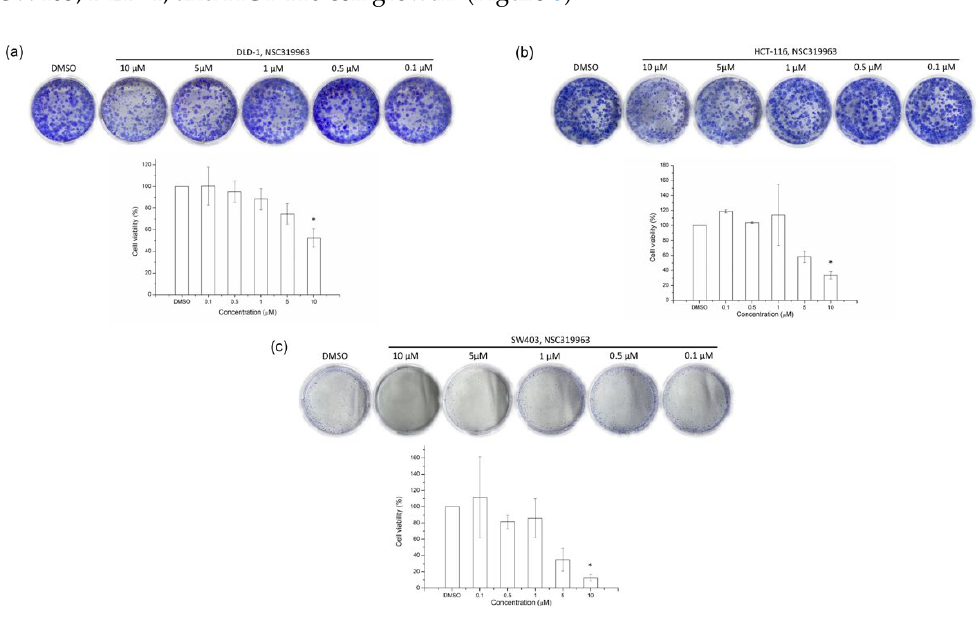
Figure 8. Inhibition of cell growth in APC colorectal cancer cells. ( a ) DLD-1 ( b ) HCT-116 and ( c ) SW403 cells were incubated with various concentrations of NSC319963 for 10 to 12 days. Colony formation was assessed to detect the effect of NSC319963 on cell growth. Colony formation was counted and presented as bar graphs. Each column represents the mean ± SD with triplicate experiments. * p < 0.05, compared to DMSO group.